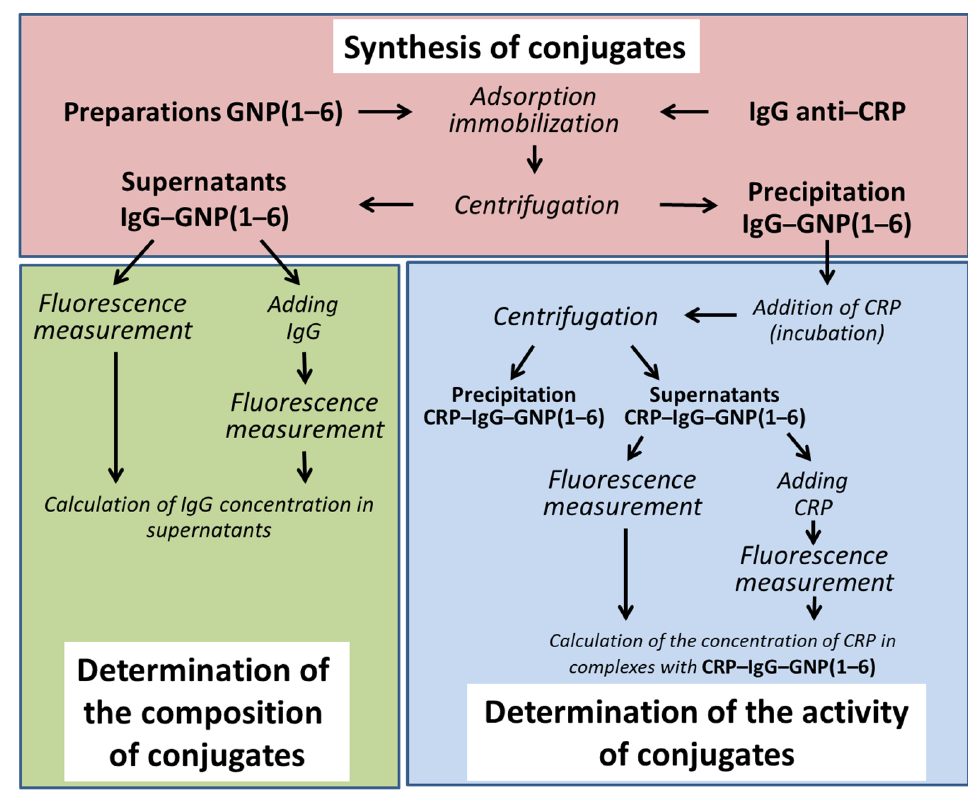
Figure 1. Schematic of the experiment to determine the number of antibodies immobilized on the GNP surface.